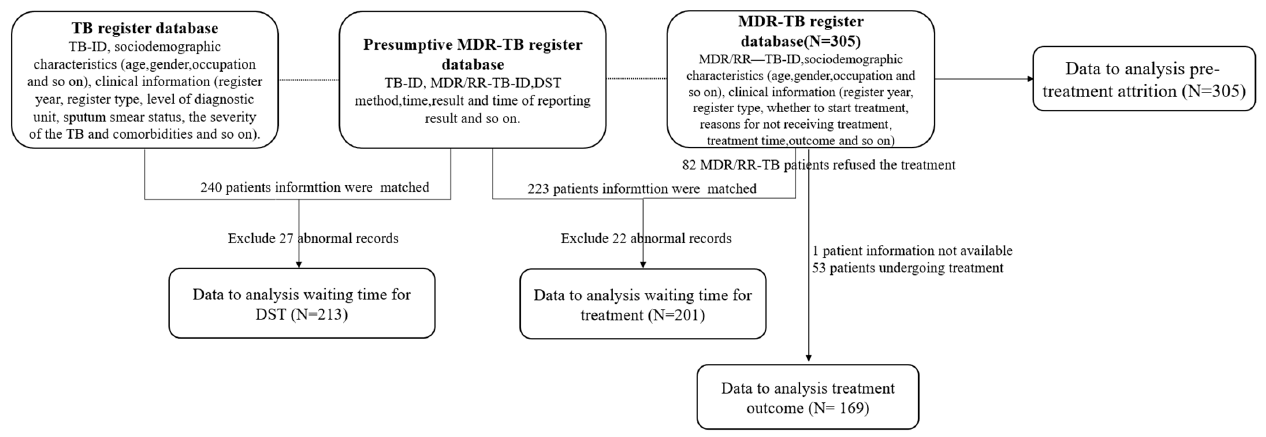
Figure 2. Flow diagram of data collection.